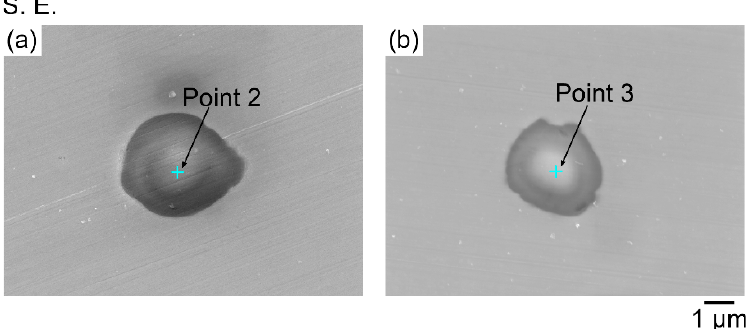
Figure 2. Anodic polarization curves measured in ( a ) 0.1 M NaCl and ( b , c ) 0.1 M NaCl-1 mM